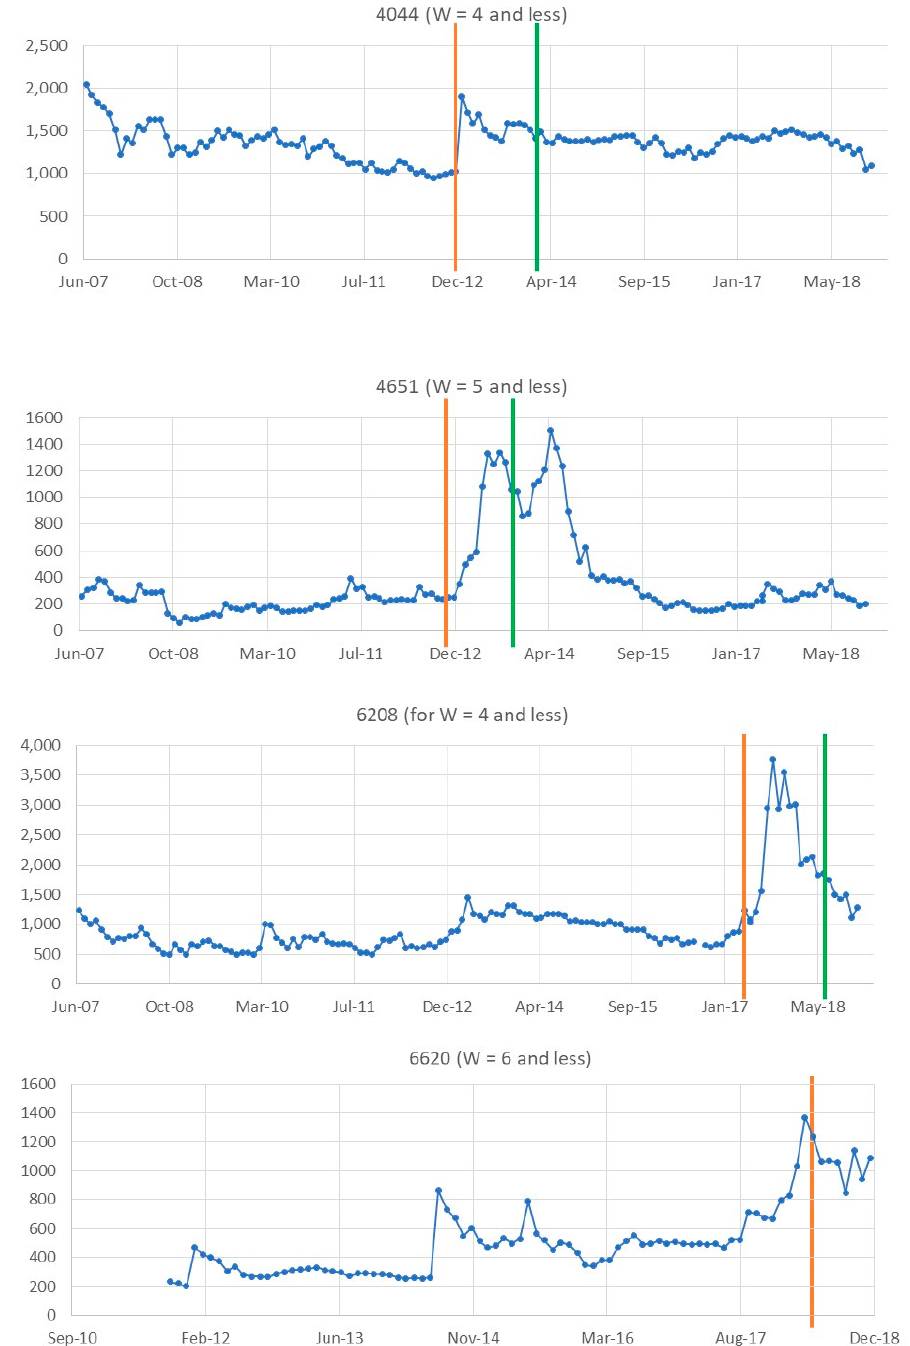
Figure 7. Examples of entrances and exits of pills for top-10 data, located on the time axis of price changing.